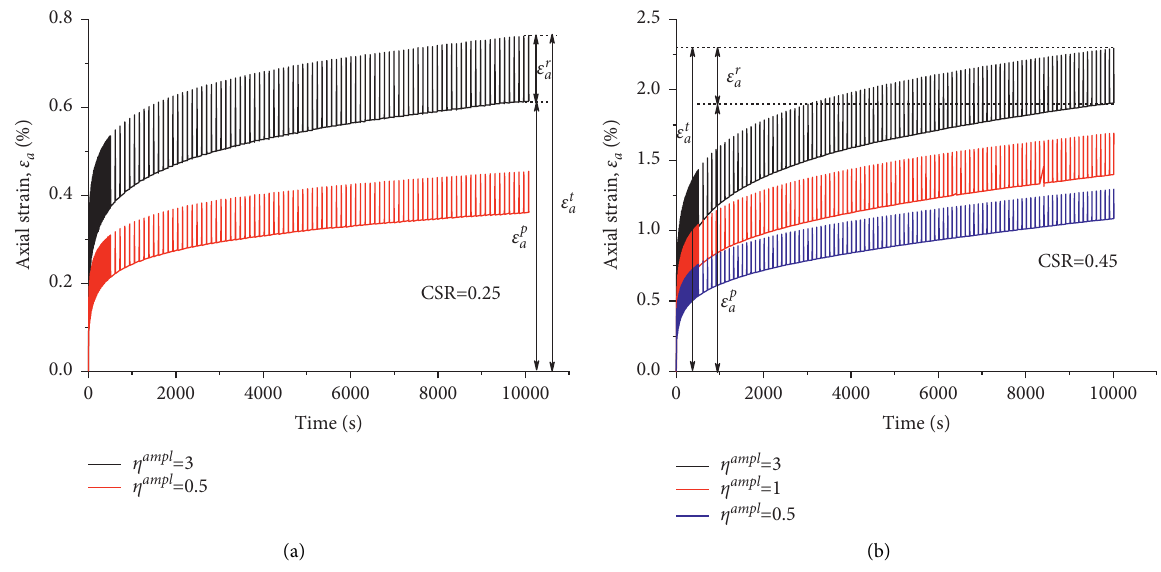
Figure 3: Typical axial strain development curves against loading time: (a) CSR � 0.25 and (b) CSR � 0.45.